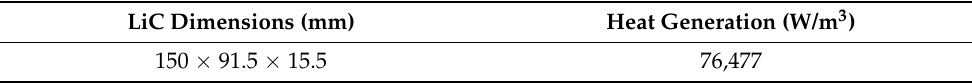
Table 3. The generated heat of the LiC regarding its dimensions for a 150 A current